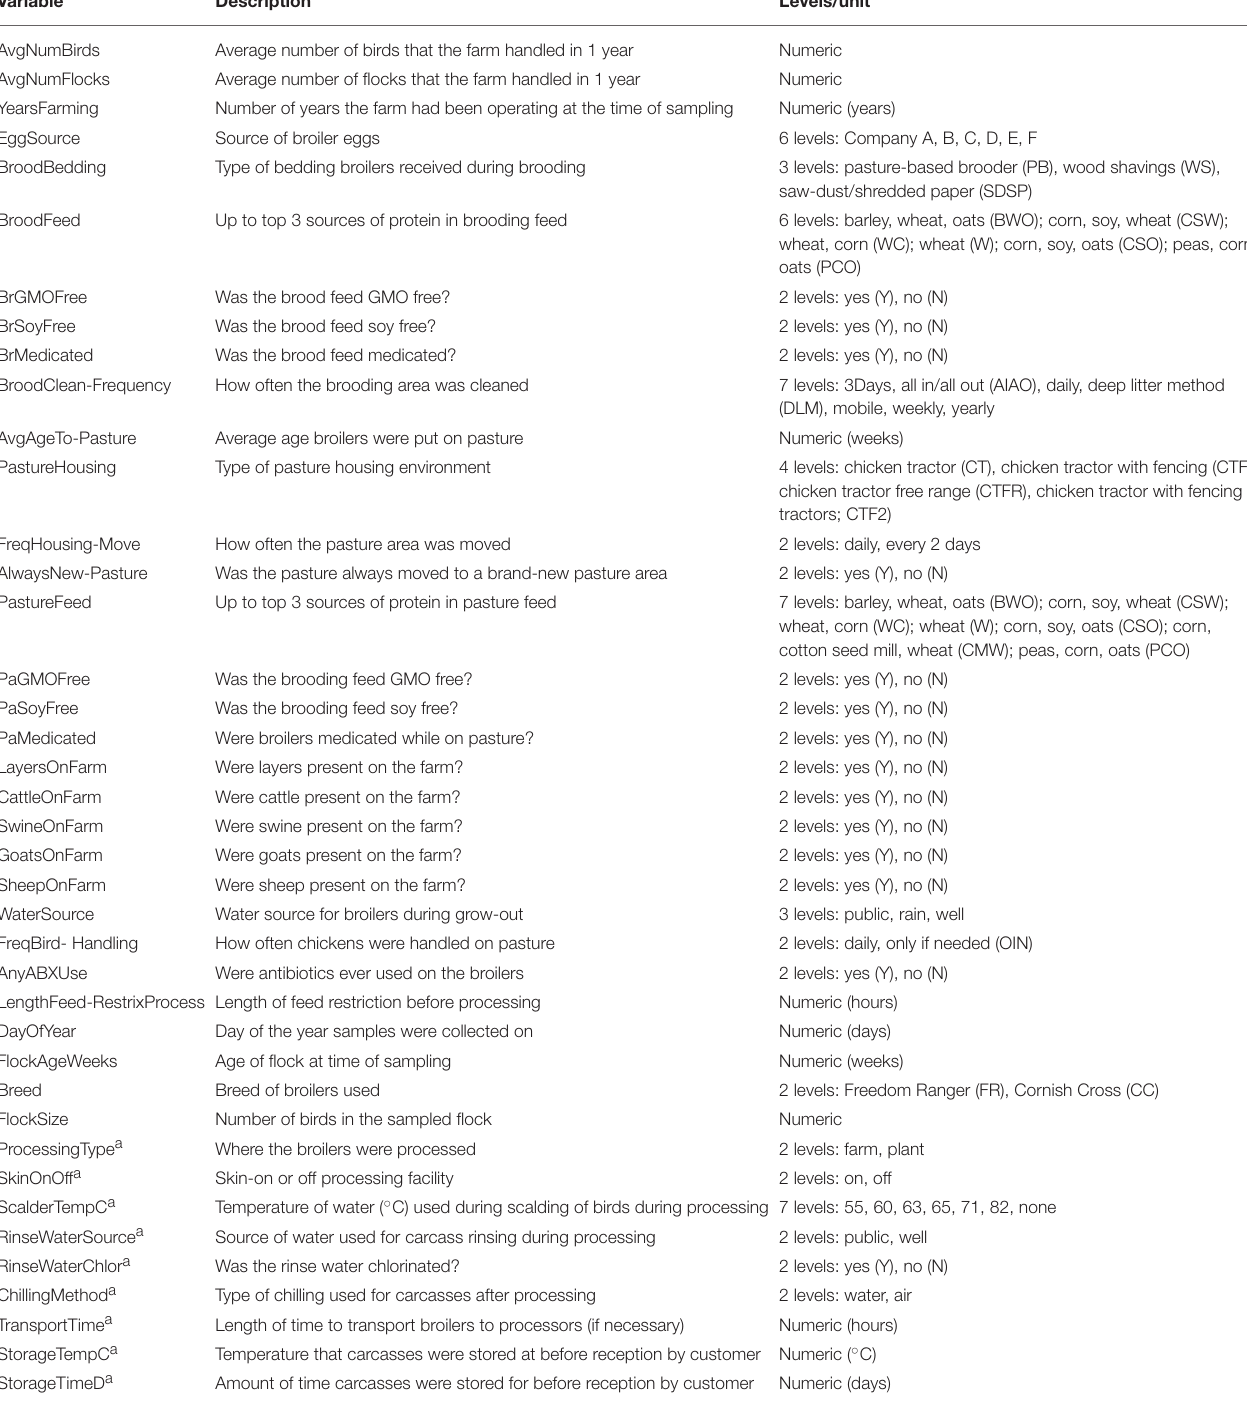
TABLE 2 | Predictors used in the preharvest (feces, soil) and final product whole carcass rinse (WCR) random forest models.